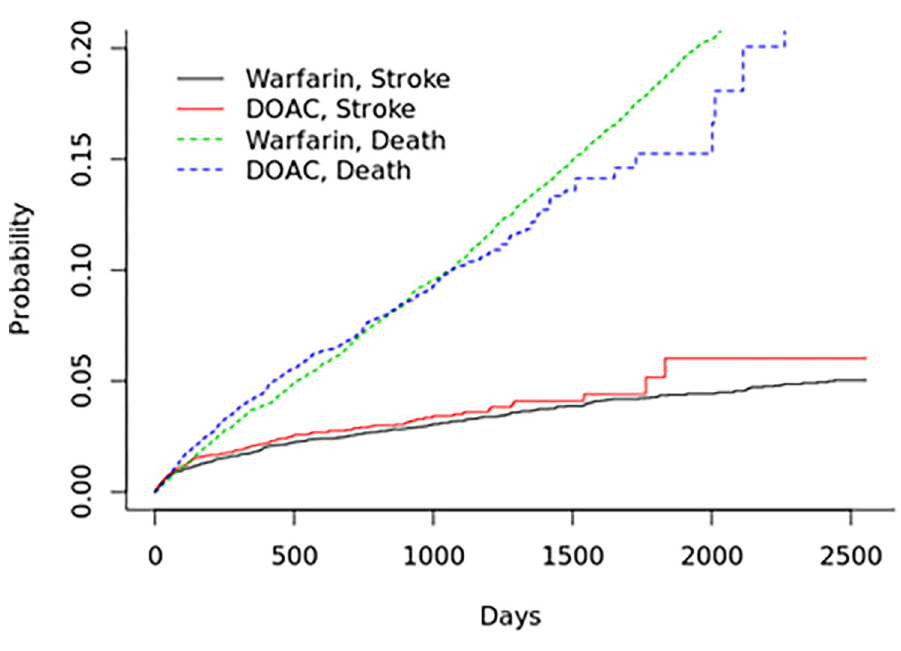
Fig 1. Unadjusted cumulative incidence of stroke and all-cause